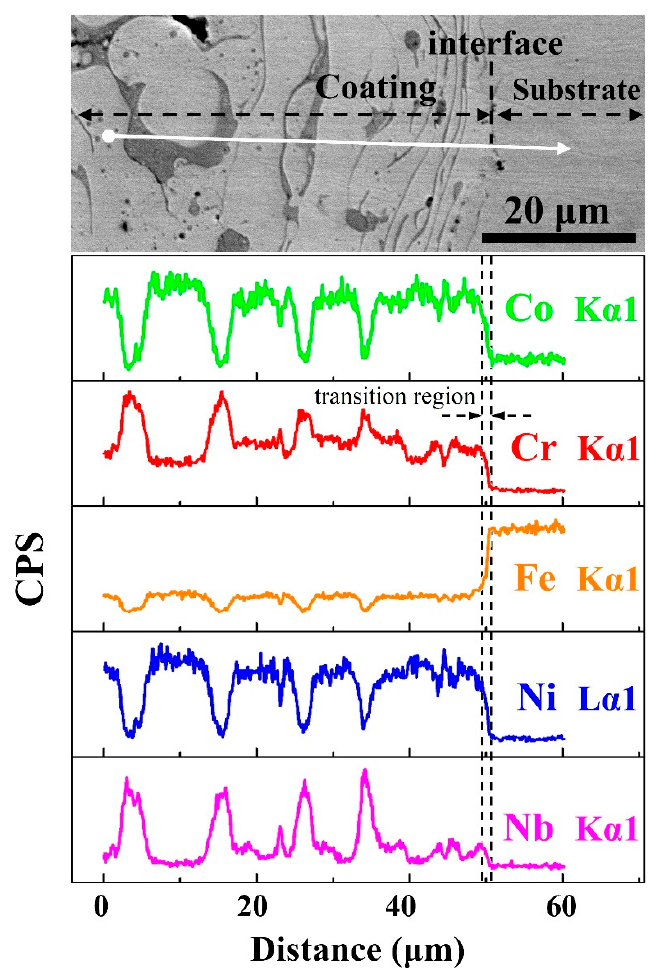
Figure 4. ( a ) SEM image of the HEA coating longitudinal section, ( b – f ) distributions of alloying elements by EDS line scanning.